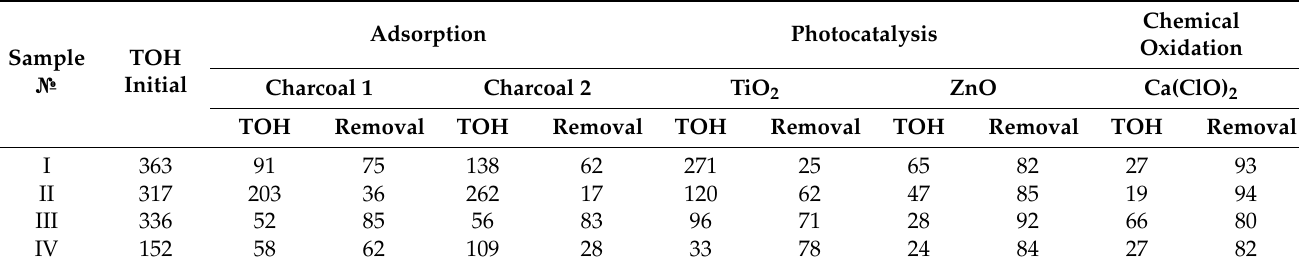
Table 4. Results from produced water treatment tests.